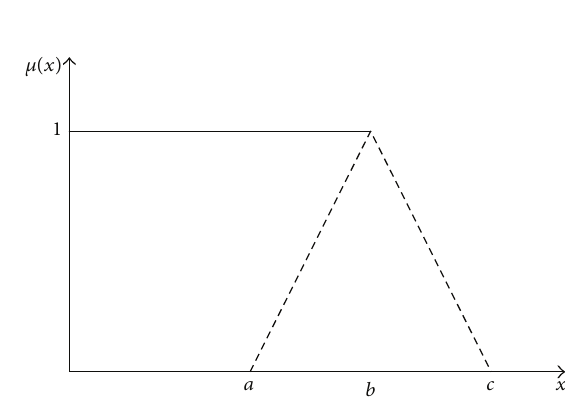
Figure 5: Triangular fuzzy number.